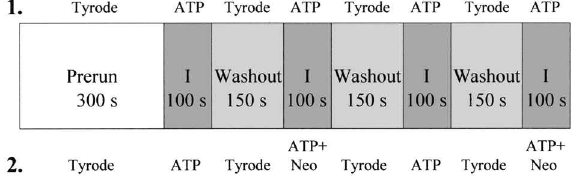
FIG. 1. Schedule for the first and second experimental protocols (I, incubation; Neo,